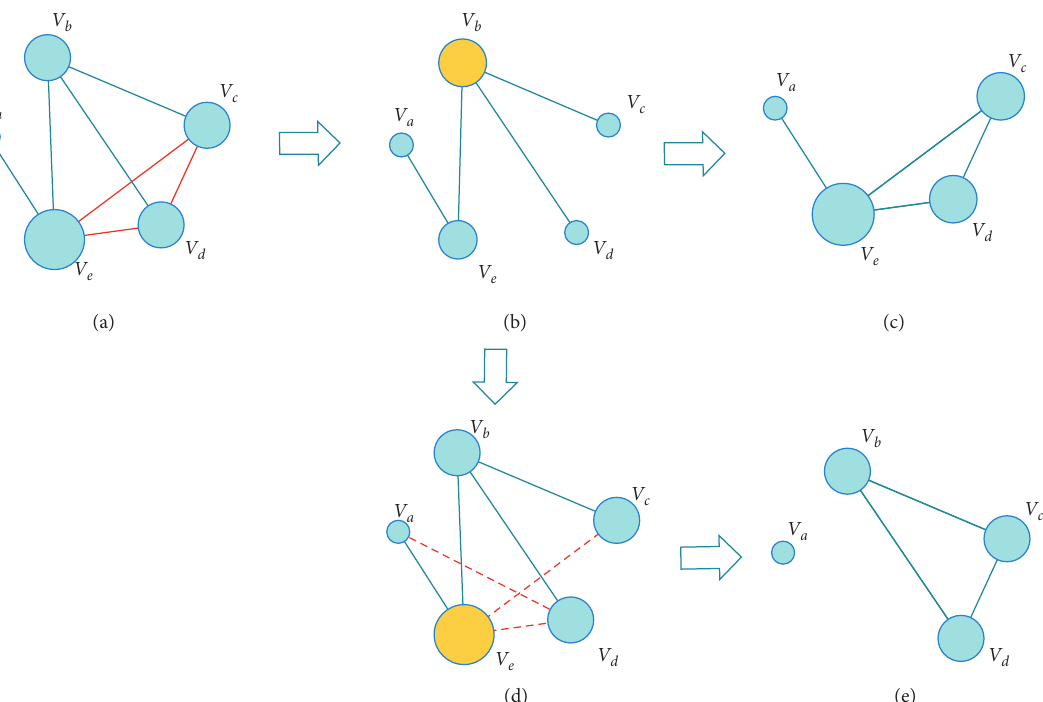
Figure 2: Comparison between the residual networks for a direct attack and attack after link prediction. (a) Complete network G . (b) Incomplete network G O with three hidden edges. (c) Residual network after node V b , which is the highest degree node in the incomplete network G O , is attacked. (d) Predicted network G P with three predicted links added (red dotted lines). (e) Residual network after node V e , which is the highest degree node in the predicted network G P , is attacked.